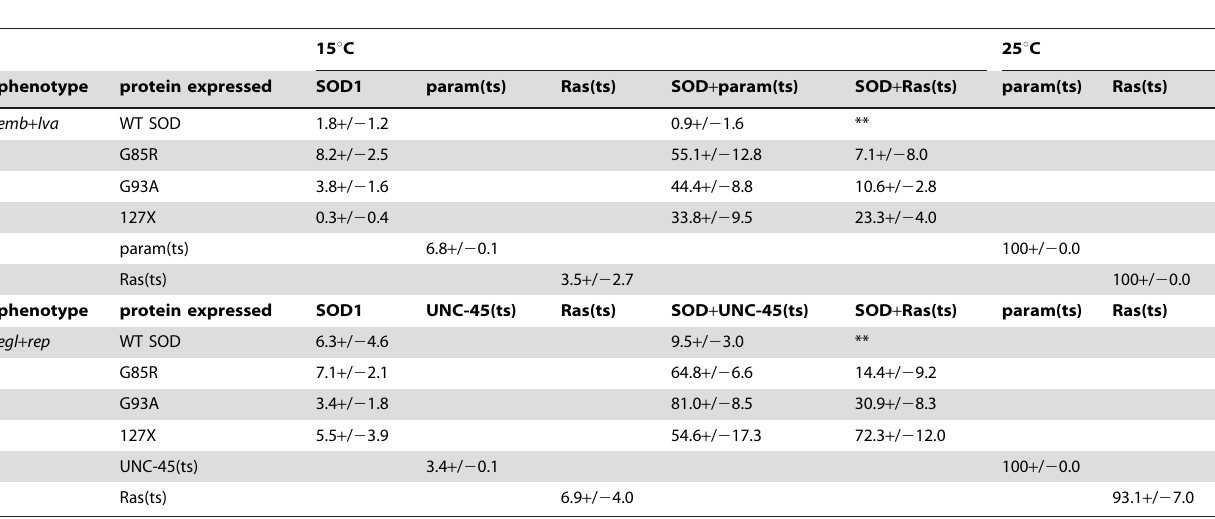
Table 1. SOD1 toxicity is modulated by destabilizing protein